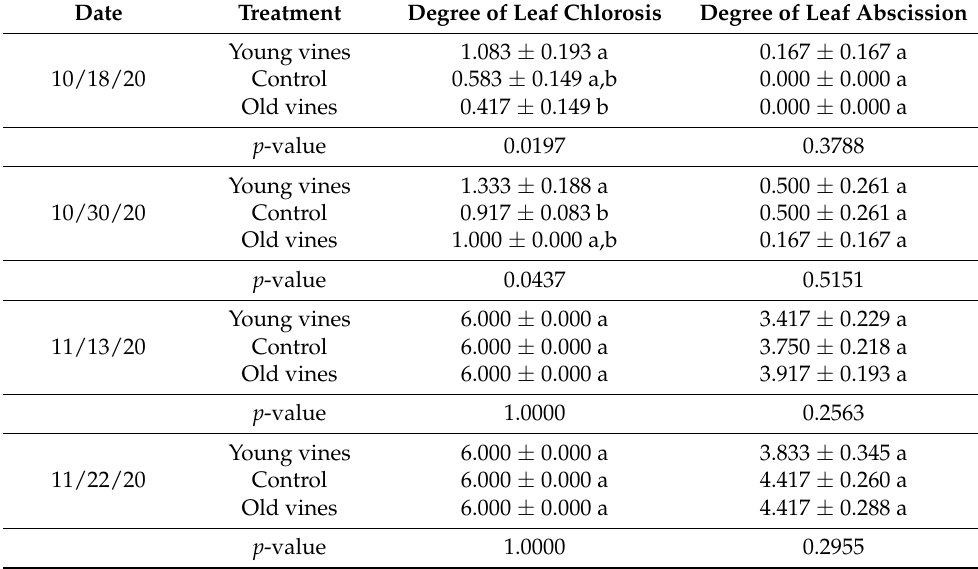
Table 3. One-way analysis of variance (ANOVA) showing senescence (leaf chlorosis and abscission) tracking during the 2020 growing season ( n = 12). Treatment means followed by standard error of the mean. Different letters within a column indicate differences between treatment groups based on Tukey HSD. Significant p -values (<0.05) are shown in the